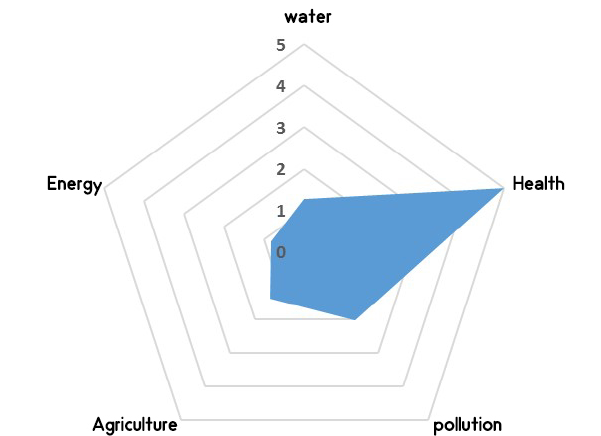
Figure 4. Importance of Nexus main